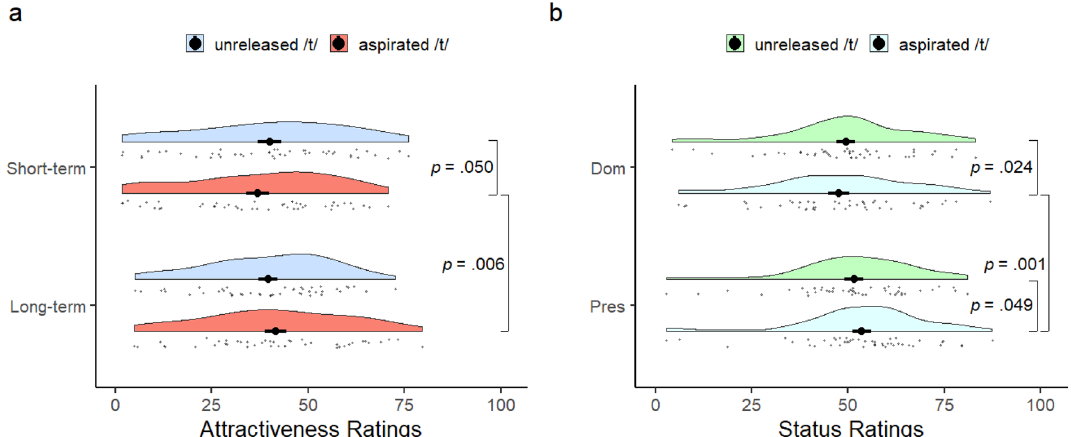
Figure 1. Differences in attractiveness and status ratings between unreleased /t/ versus aspirated /t/. Raincloud plots show ( a ) short-term and long-term attractiveness ratings, and ( b ) dominance and prestige ratings for unreleased /t/ versus aspirated /t/. The solid dot with lines extendending at the center of each of the rainclouds depicts means and standard errors. Short-term short-term attractiveness, long-term long-term attractiveness, Dom dominance, Pres